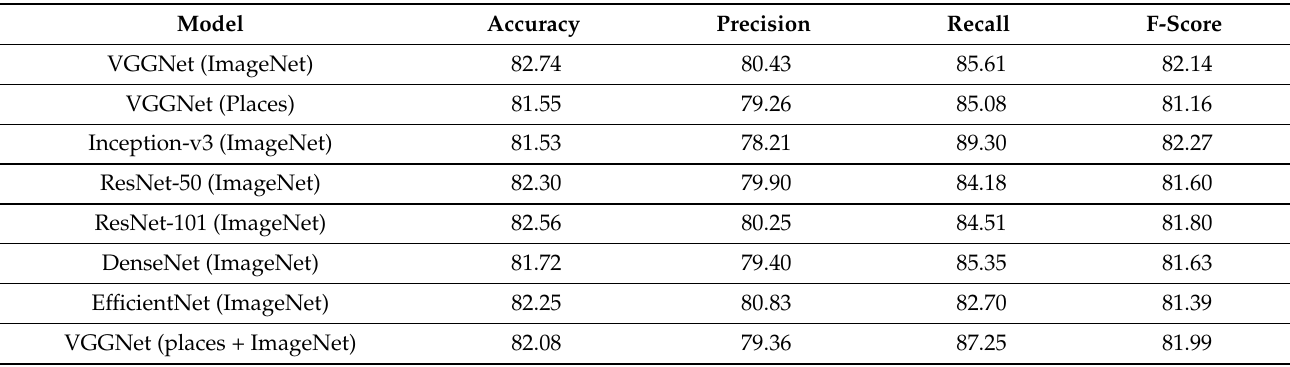
Table 8. Evaluation of the proposed visual sentiment analyzer on task 3 (i.e., multi-label classification of seven classes, namely anger, anxiety, craving, empathetic pain, fear, horror, joy, relief, sadness, and